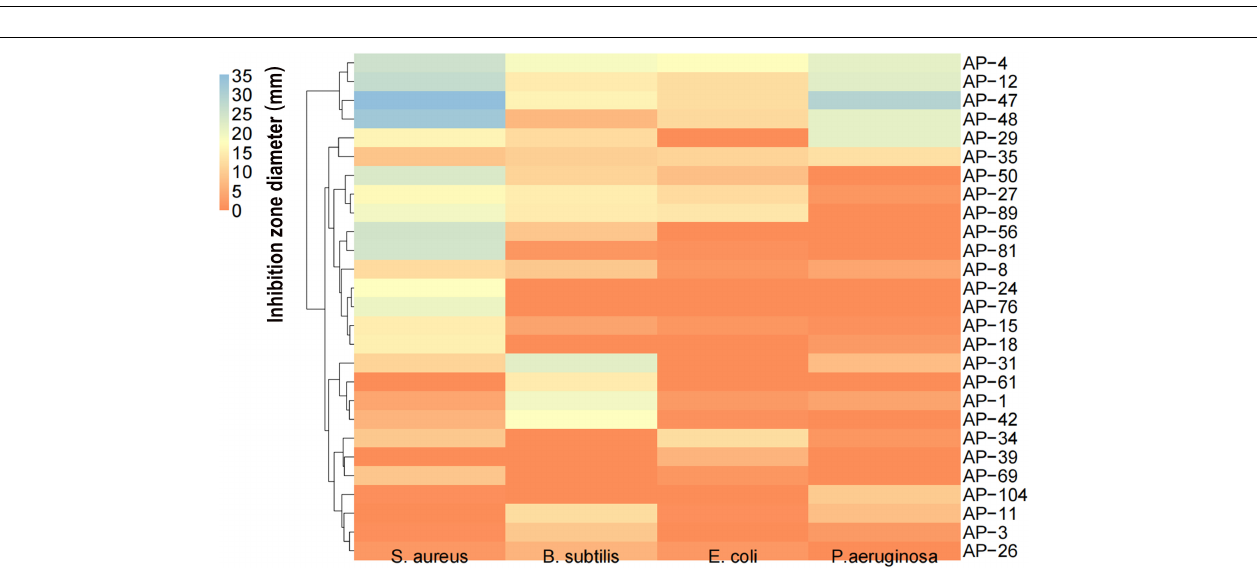
FIGURE 6 | HCA of antioxidant capacity of 32 dominant endophytic fungi mycelial extractions (MEs) against S. aureus , and B. subtilis , E. coli , and P. aeruginosa .